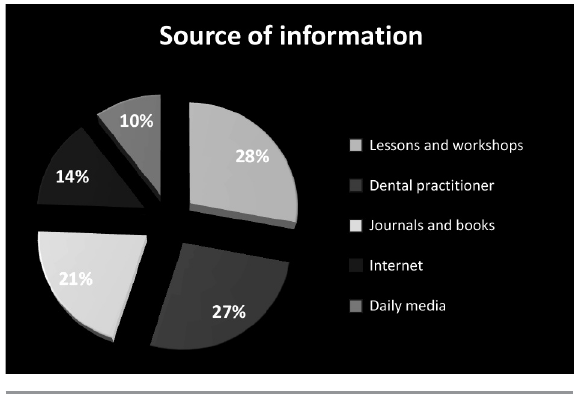
Figure 2. Source of information regarding the relationship between PD and systemic disease/conditions.